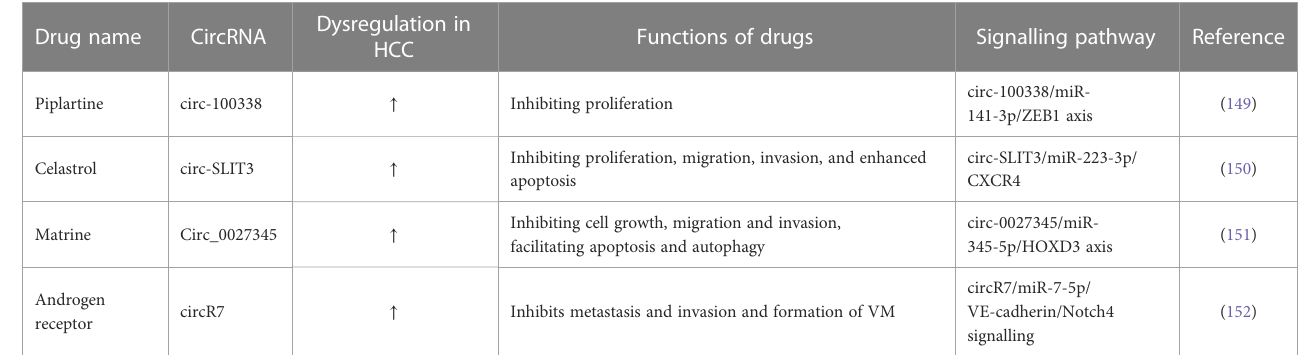
TABLE 3 Summary of drugs and their targeted circRNAs in